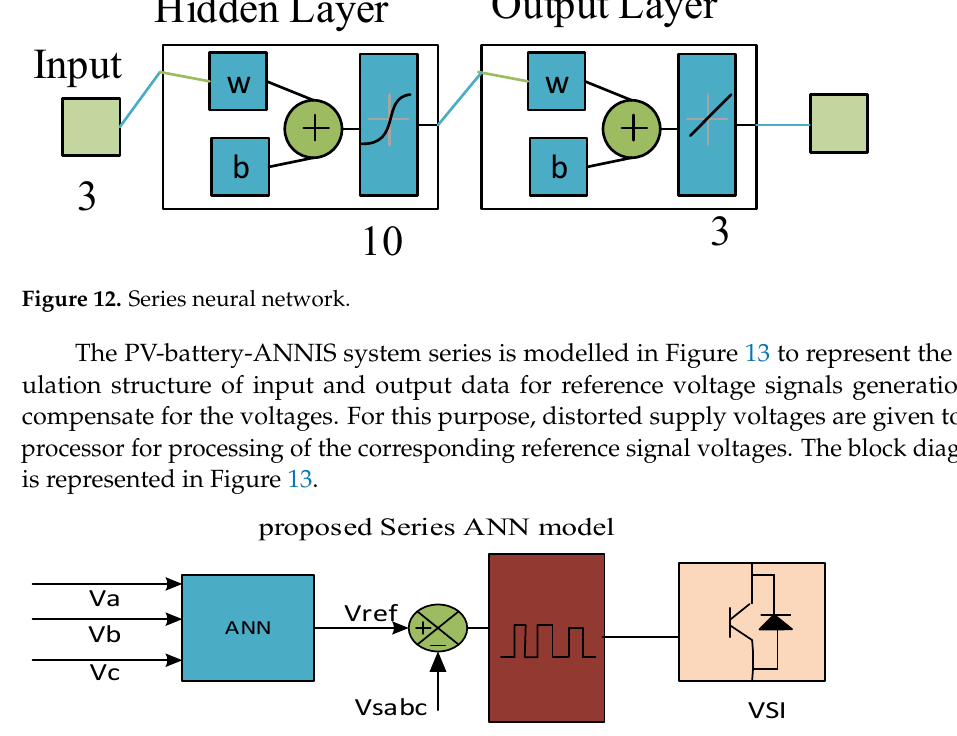
13 of 28 Figure 11. Shunt ANN model development. 2.3.3. Series Controller Based on ANN The series compensator is the part of the UPQC which is used for mitigation of volt- age related problems such as, voltage flickers, sag/swell and harmonics in voltages [17]. In this compensator, reference voltages are generated for injection of voltages to the net-